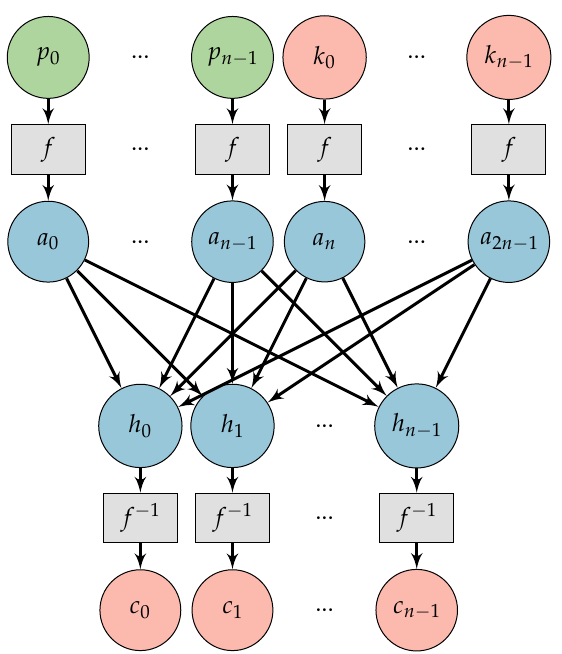
Figure 3. The proposed neural network ( CryptoNet ). The bits of the plaintext are represented by [ p 0 , p 1 ,..., p n − 1 ]. The bits of the key are represented by [ k 0 , k 1 , ..., k n − 1 ]. The function f (see Equation (9)) transforms the bits into angles [ a 0 , a 1 , ... a 2 n − 1 ]. A fully connected layer combines the angles forming the variables [ h 0 , h 1 , ..., h n − 1 ]. The function f − 1 (see Equation (10)) transforms the combined angles into continuous bits (real numbers in the interval [ 0,1 ] ) [ c 0 , c 1 , ..., c n − 1 ] representing the